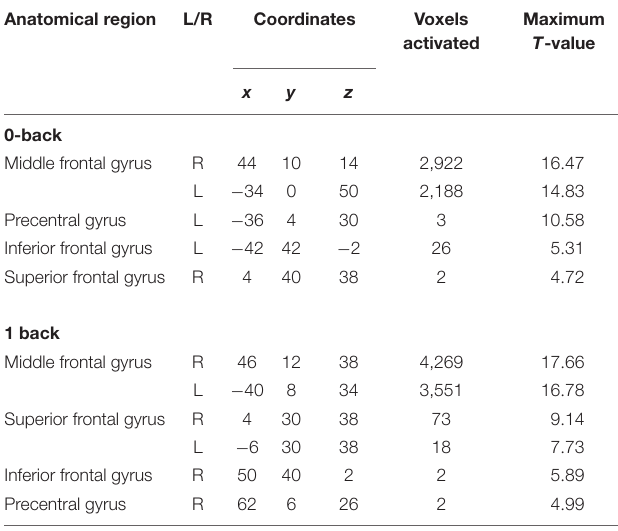
TABLE 2 | Activated brain regions during 0-back and 1-back task [ p < 0.05, family-wise error (FWE) corrected]. Anatomical region L/R Coordinates Voxels